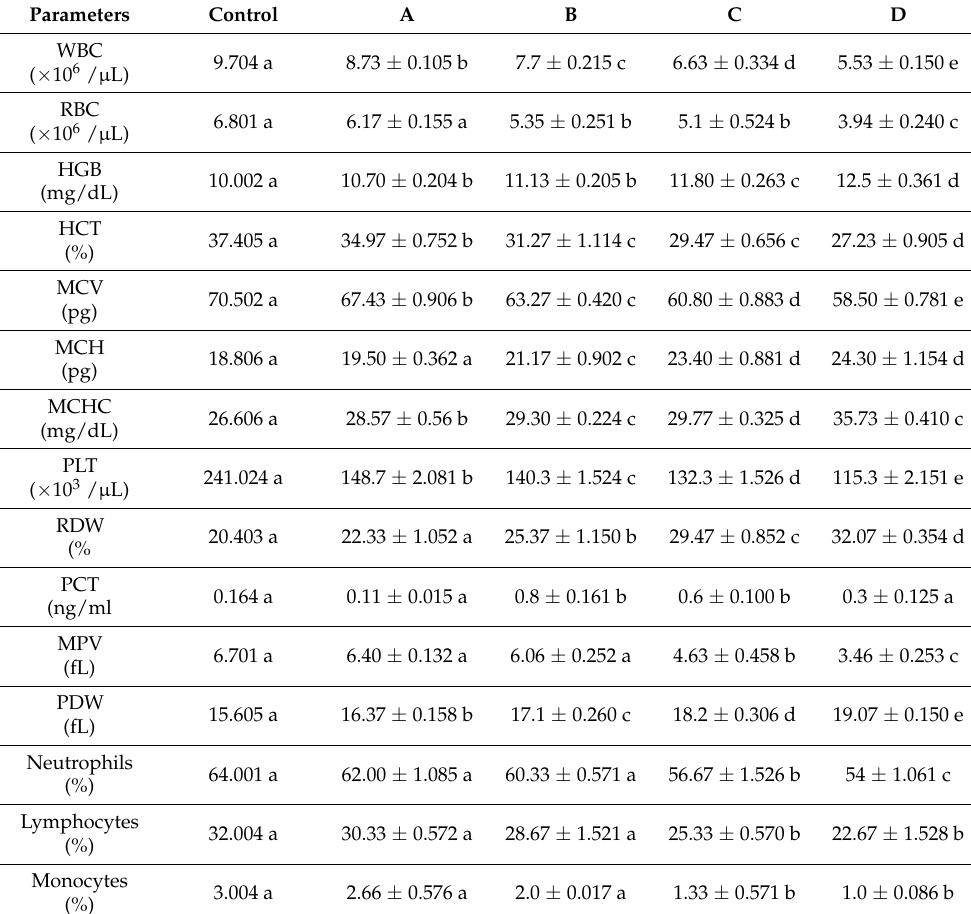
Table 3. Blood hematological parameters of control and groups fed with flower methanolic extract of P. hysterophorus .